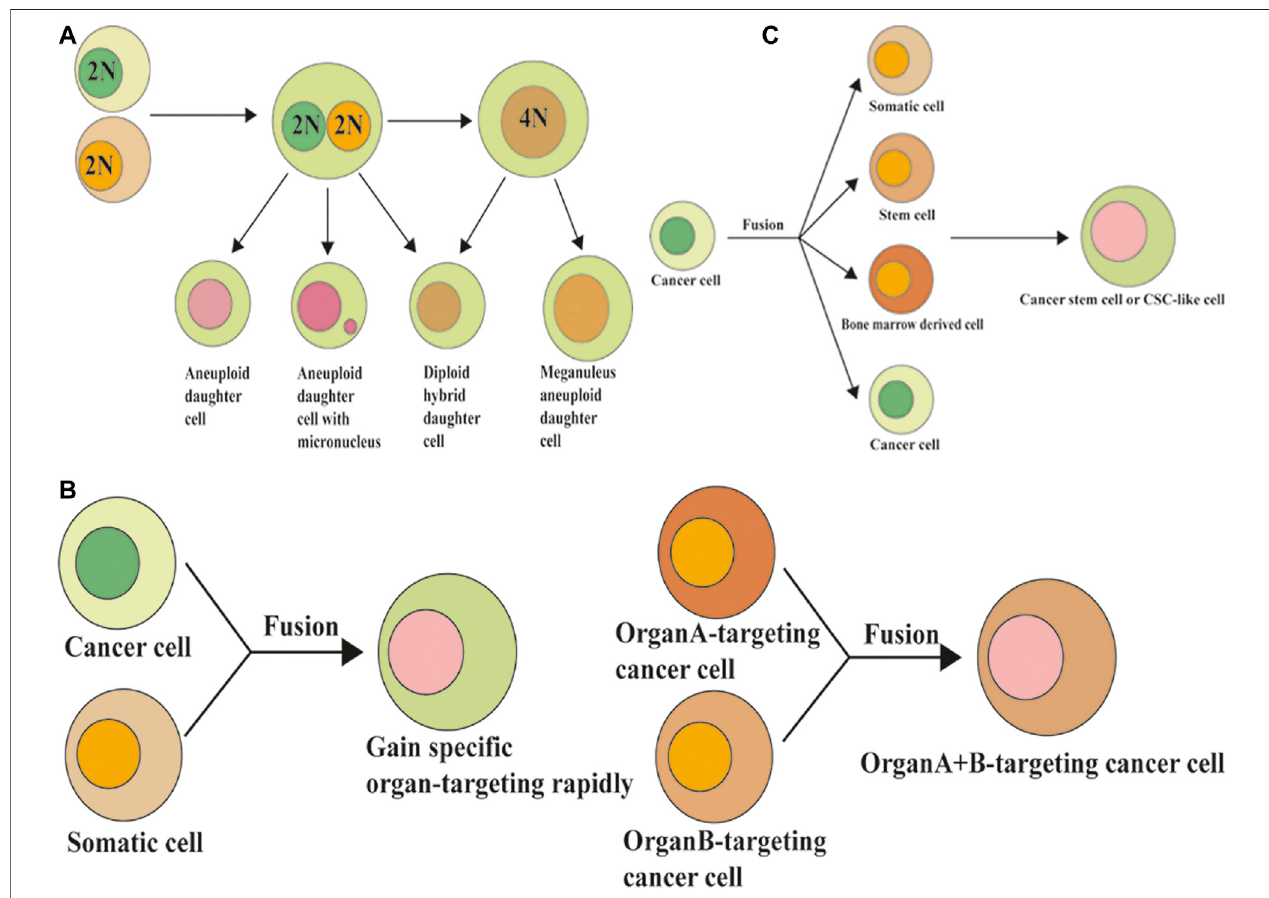
FIGURE 4 | Cell fusion and the formation of polyploidy, organ-speci fi c metastasis, and formation of cancer stem cells. (A) Cell fusion induced polyploidy, aneuploidy, and genomic instability. (B) Cell fusion and organ-speci fi c metastasis of cancer cells. (C) Cell fusion and the formation of cancer stem cells.